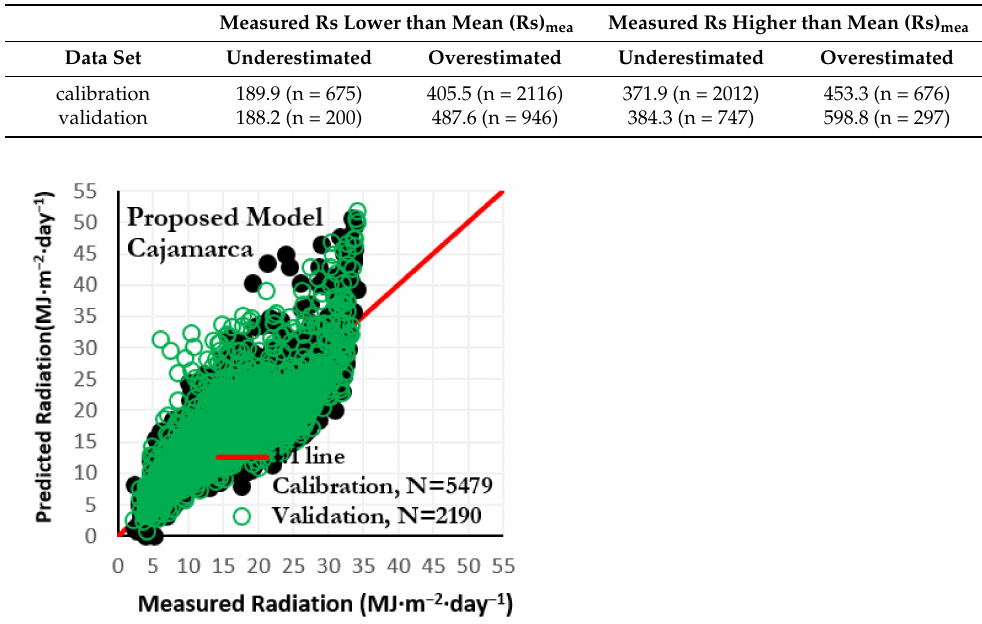
Table 8. RMSE values (J · cm − 2 · day − 1 ) and number of data points in under- and overestimation sets for measured solar radiation values lower or higher than mean (Rs) mea in calibration and validation sets.